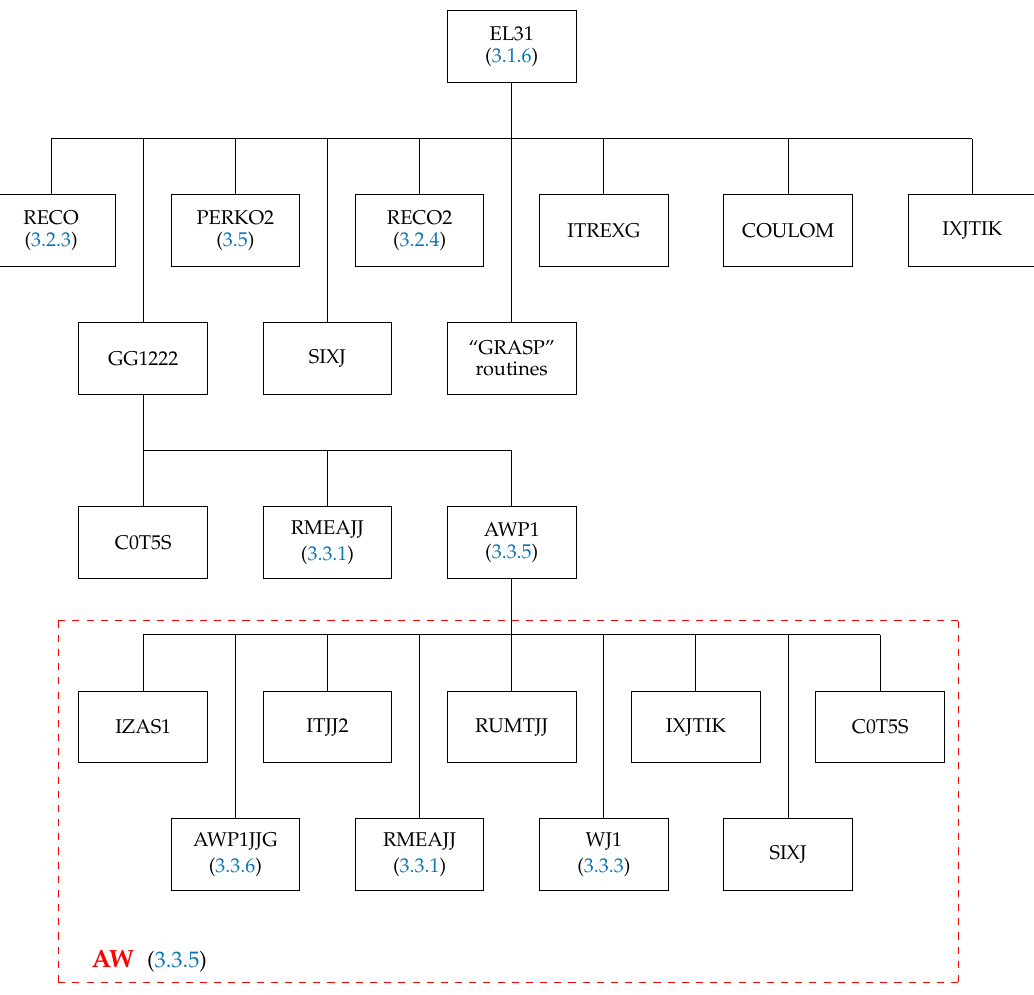
Figure 5. Structure of the subroutine EL31 . The box “GRASP” routines corresponds to the routines SNRC , CXK , SPEAK , and TALK from the GRASP92 package [54]. The red frame AW shows the structure of the routine AWP1 (computing the matrix element (92)) to which the subroutine EL31 explicitly is